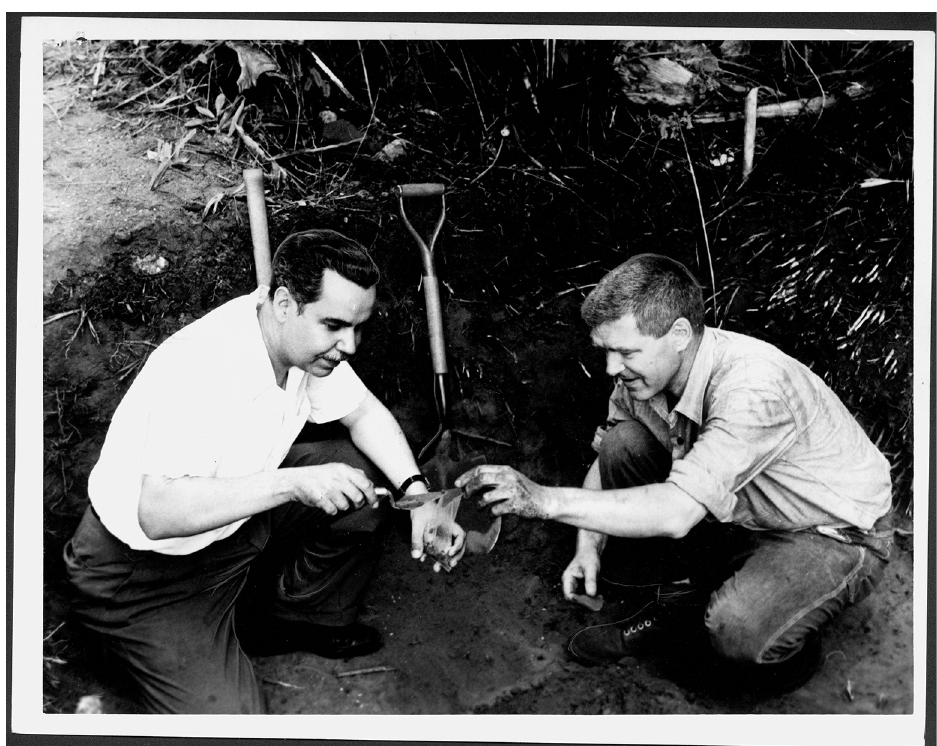
Fig 1. Ricardo Alegrı´a (left) and Irving Rouse (right) obtaining radiocarbon dates from Marı´a de la Cruz Cave, Loı´za, July 13, 1962. Note bulk sample size and methods of sample collection, both of which would affect the dates obtained. Image available at Biblioteca Digital Puertorriqueña , https://upr.contentdm.oclc.org/digital/collection/ELM4068/id/ 408/rec/16).